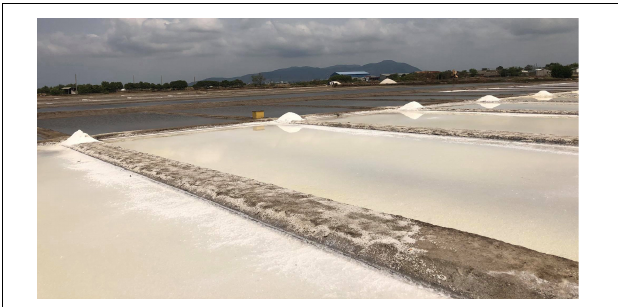
FIGURE 1 | Typical solar salt production fields in